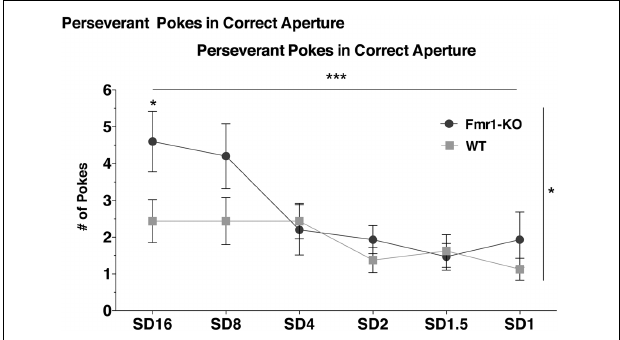
FIGURE 3 | Heightened perseverative behavior in Fmr1 -KO mice. Fmr1 -KO and WT littermate mice significantly reduced the number of perseverative responses made in the correct illuminated hole over the entire training phase. However, Fmr1 -KO mice poked significantly more at SD16 than WT. Data was analyzed with a 2-way repeated measures ANOVA with Bonferroni’s post-test analysis. Asterisks indicate significance levels; ∗∗∗ p < 0 . 001, ∗ p < 0 . 05.